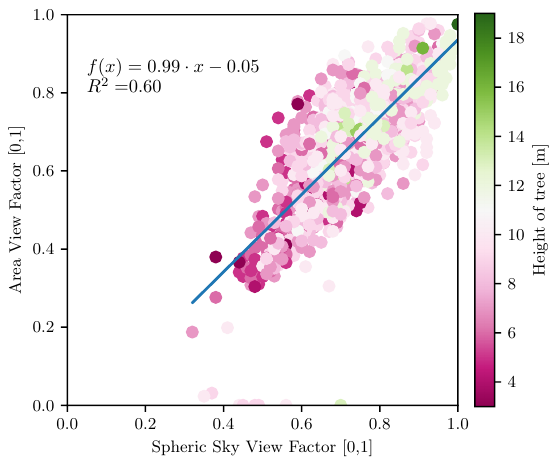
Figure 12. Direct comparison between Sky View Factor based on top of each tree and virtually remote sensed Area View